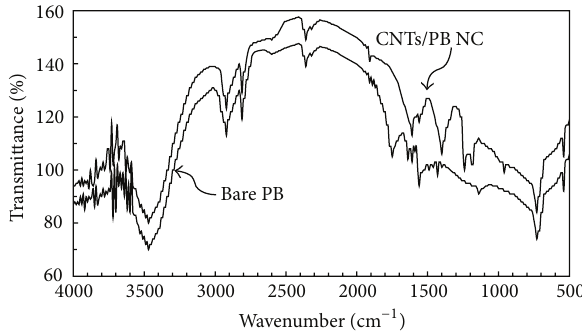
Figure 1: FT-IR spectra of base Polybond and one of the represen- tative samples of CNTs/PB